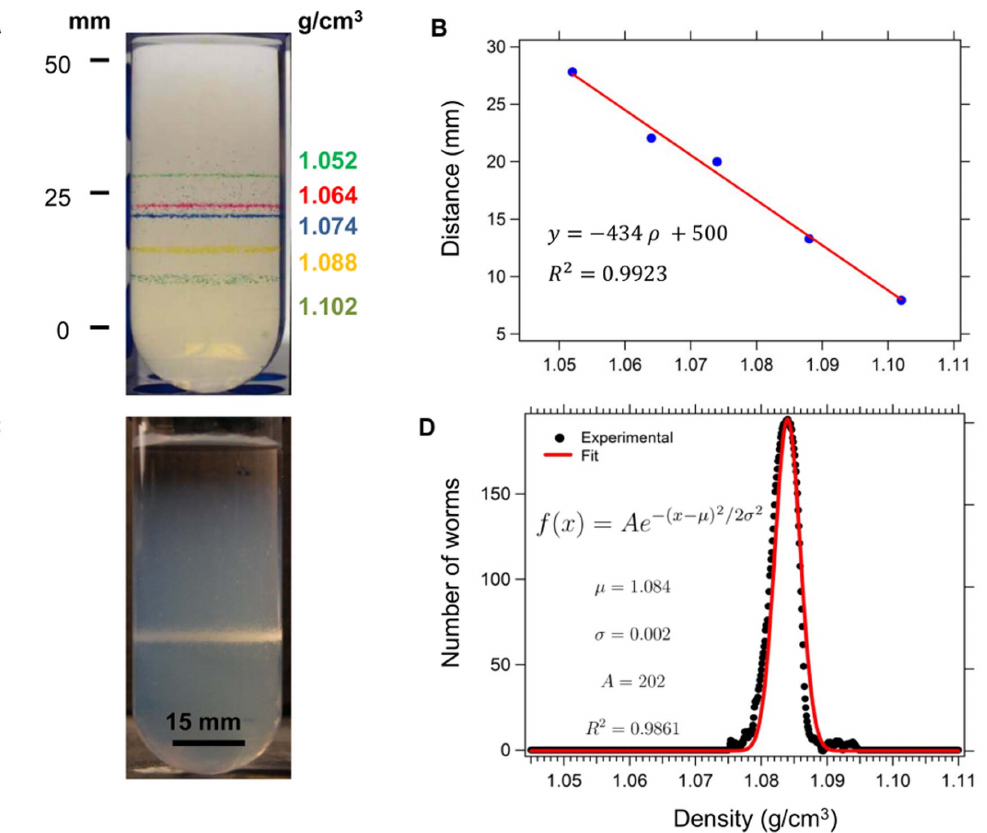
Figure 1. The distribution of mass densities of populations of C.elegans can be measured through isopycnic centrifugation in linear Percoll TM gradients. (A) Image of a typical Percoll TM centrifugation medium, with density-standard beads. (B) Plot of the height of the beads versus their intrinsic densities. Each point in the plot is an average of seven measurements, error bars are within the size of the points on the graph. (C) Typical image of cold-immobilized worms, (here, immediately after the L4/adult molt), after centrifugation in the gradient. (D) Distribution of densities of the worms in (C). The red line shows a Gaussian fit to the data.